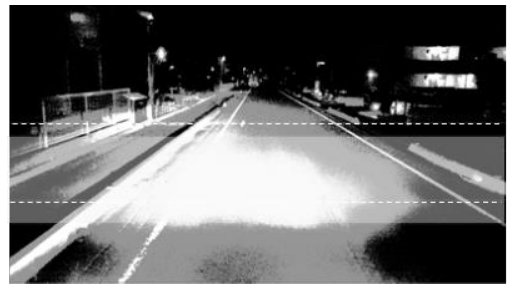
Figure 9 . Trimming range (with calibration).